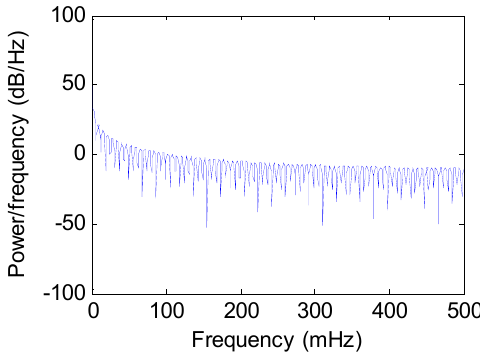
Figure 4. The power spectral density of the gravimeter data after filtering (27 May).